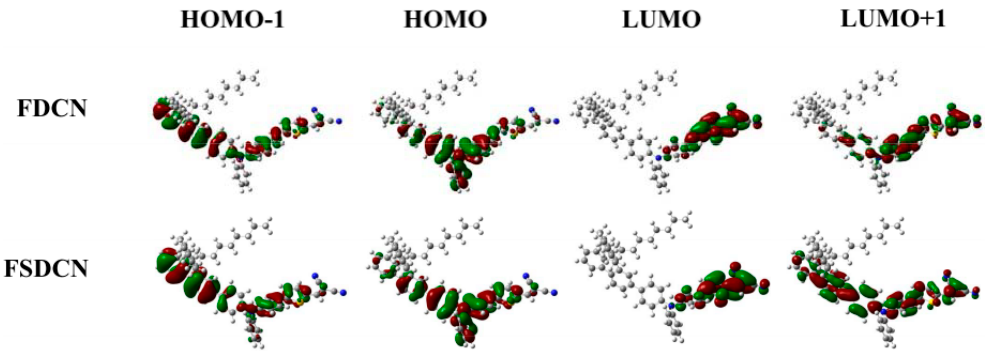
Figure 7. Plots of electron density of the indicated molecular orbitals for FDCN and FSDCN monomer.